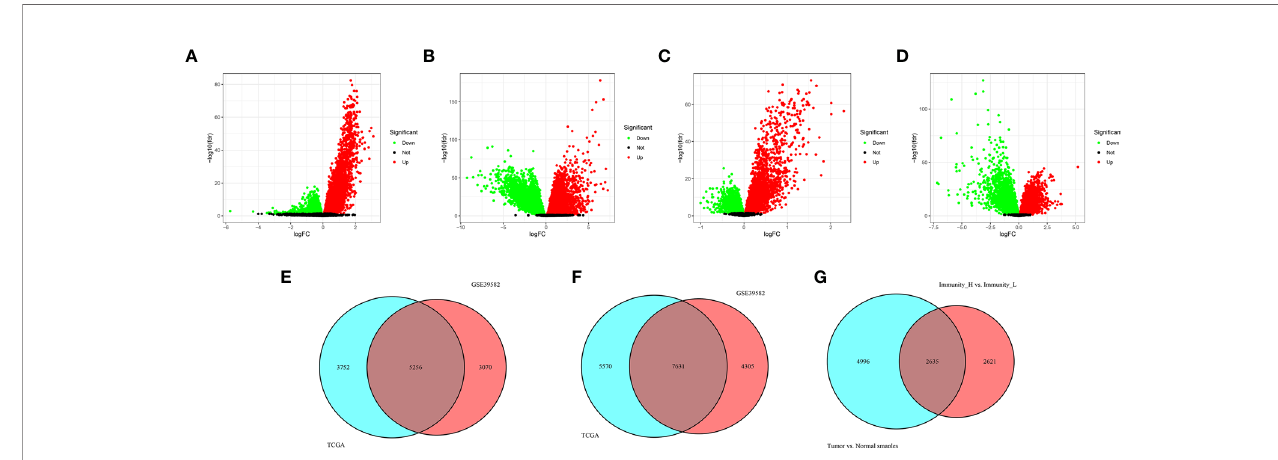
FIGURE 4 | Identi fi cation differentially expressed genes. (A, B) The volcano plots showed the differential genes between Immunity_H and Immunity_L (A) , and between CRC and normal tissues (B) in the TCGA cohort. Each red dot represents upregulated gene, each green dot represents upregulation gene, and each black dot represents no signi fi cant difference gene. (C, D) The volcano plots showed the differential genes between Immunity_H and Immunity_L (C) , and between CRC and normal tissues (D) in the GSE39582 cohorts. (E) Overlapping differential genes between Immunity_H and Immunity_L in the TCGA and GSE39582 cohorts. (F) Overlapping differential genes between CRC and normal tissues in the TCGA and GSE39582 cohorts. (G) A total of 2,635 overlapping DEGs were